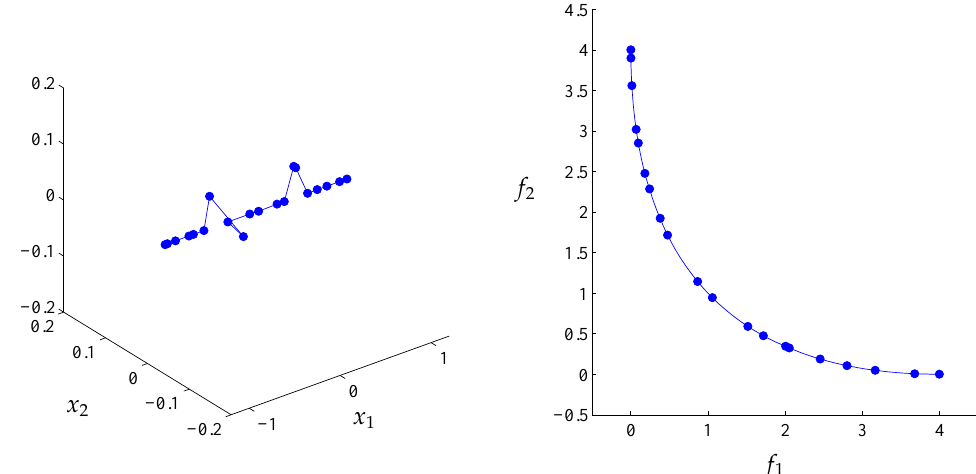
Figure 25. The same as in Figure 24 but for the 400th generation.